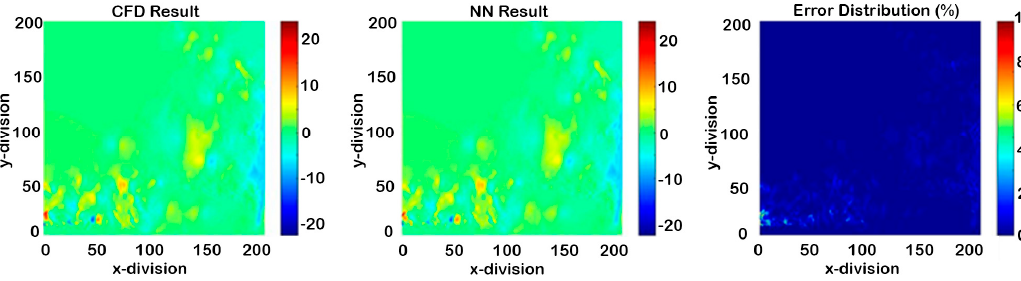
Figure 25. Cascading results of Model Ⅱ for Y -direction velocity (seven time-steps after deployment).